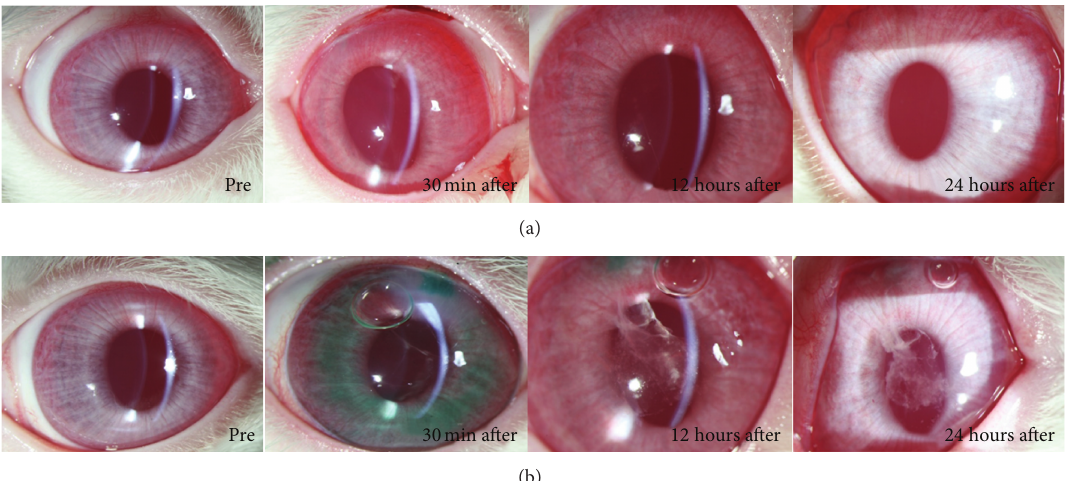
Figure 5: A very severe inflammation for up to 24 hours was observed in the eye to which 1.00% ICG had been applied (b). There was no inflammation in the eye treated with 0.25% ICG